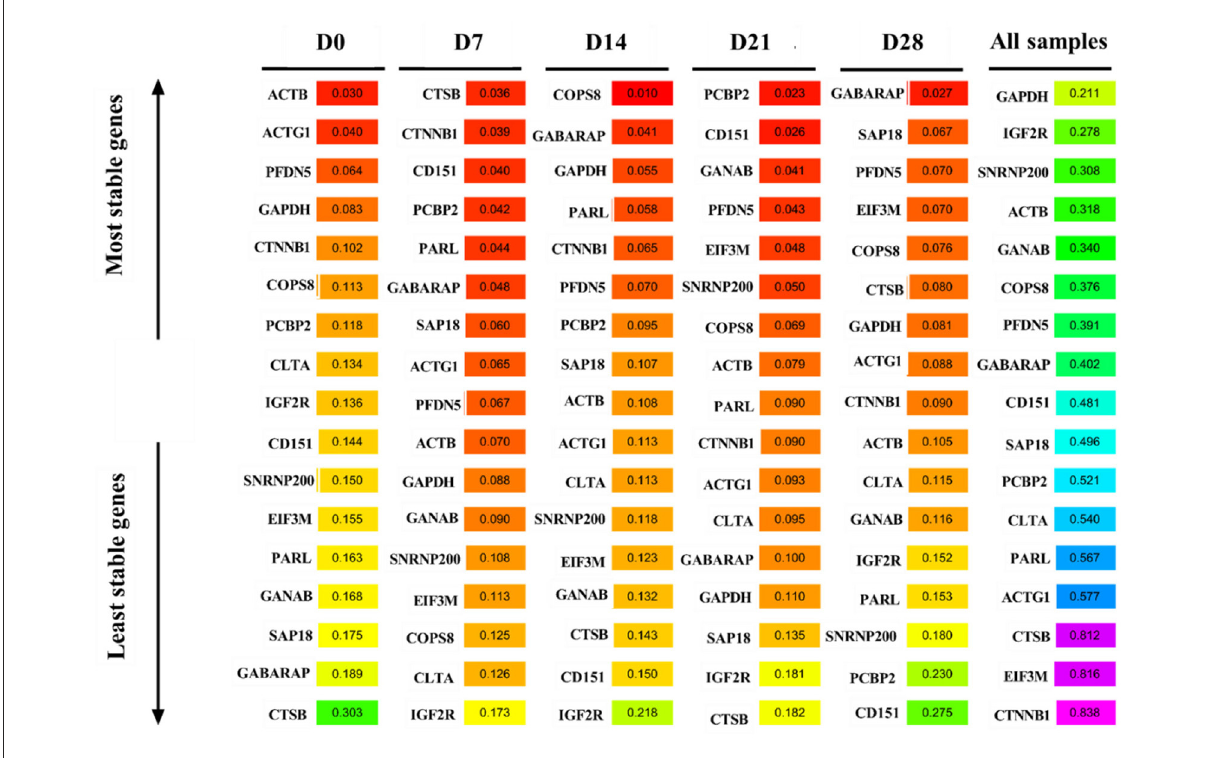
FIGURE6 BestKeeper analysis the expression stability of candidate reference